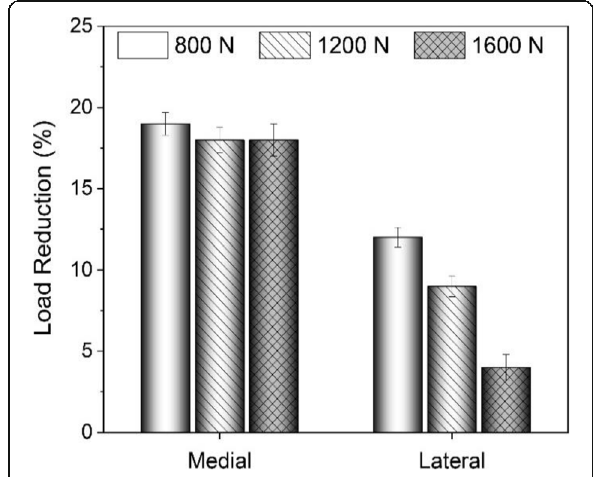
Fig. 14 Load reductions in both compartments after attachment of the implant